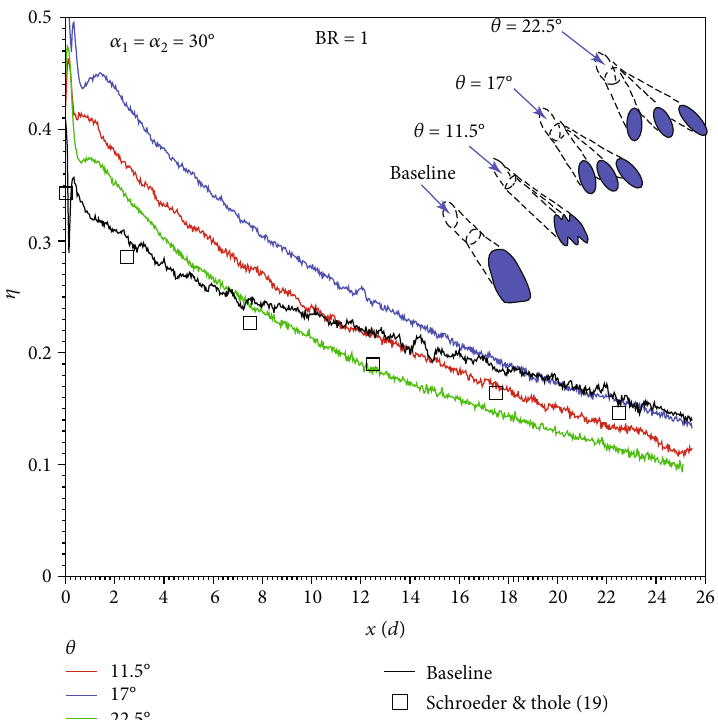
Figure 18: Streamwise (laterally averaged) fi lm e ff ectiveness variations for α BR = 1